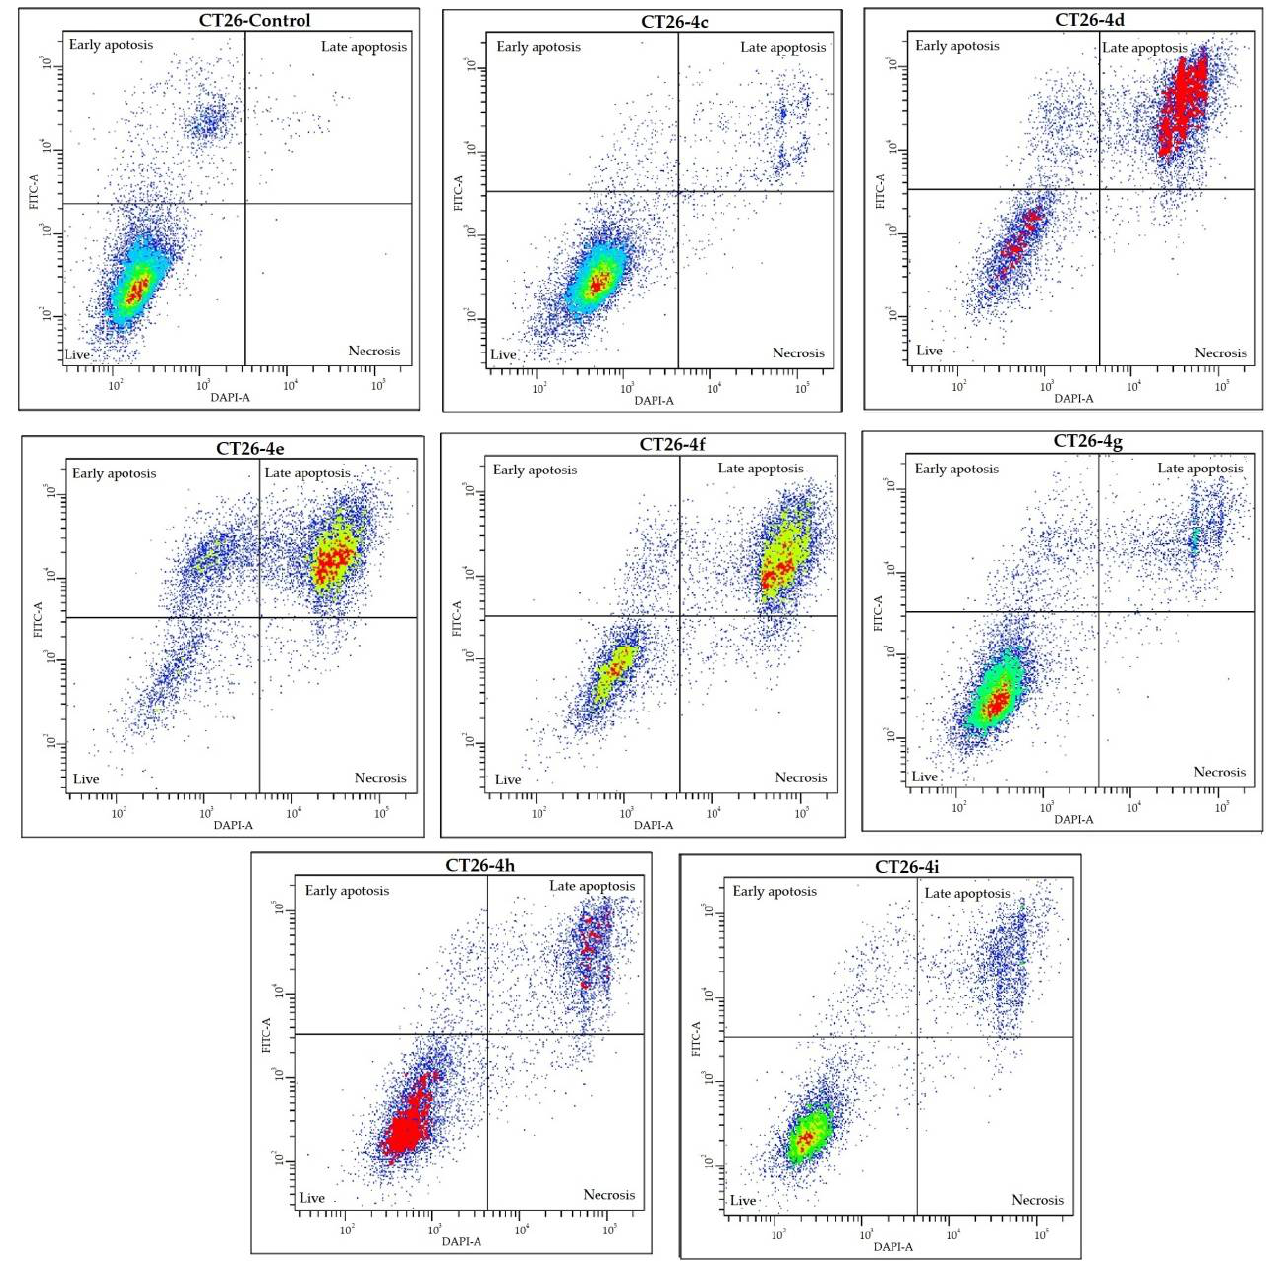
Figure 7. Apoptotic activity of CT26 cells treated with spiro-fused cycloadducts 4c – i at concentration 10 µ g/mL for 72 h using flow cytometry. Table 2. Apoptotic activity of HeLa (A) and CT26 (B) cells under the treatment with